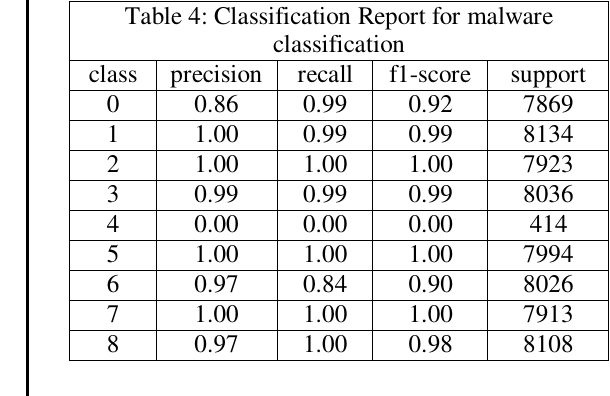
Table 4: Classification Report for malware